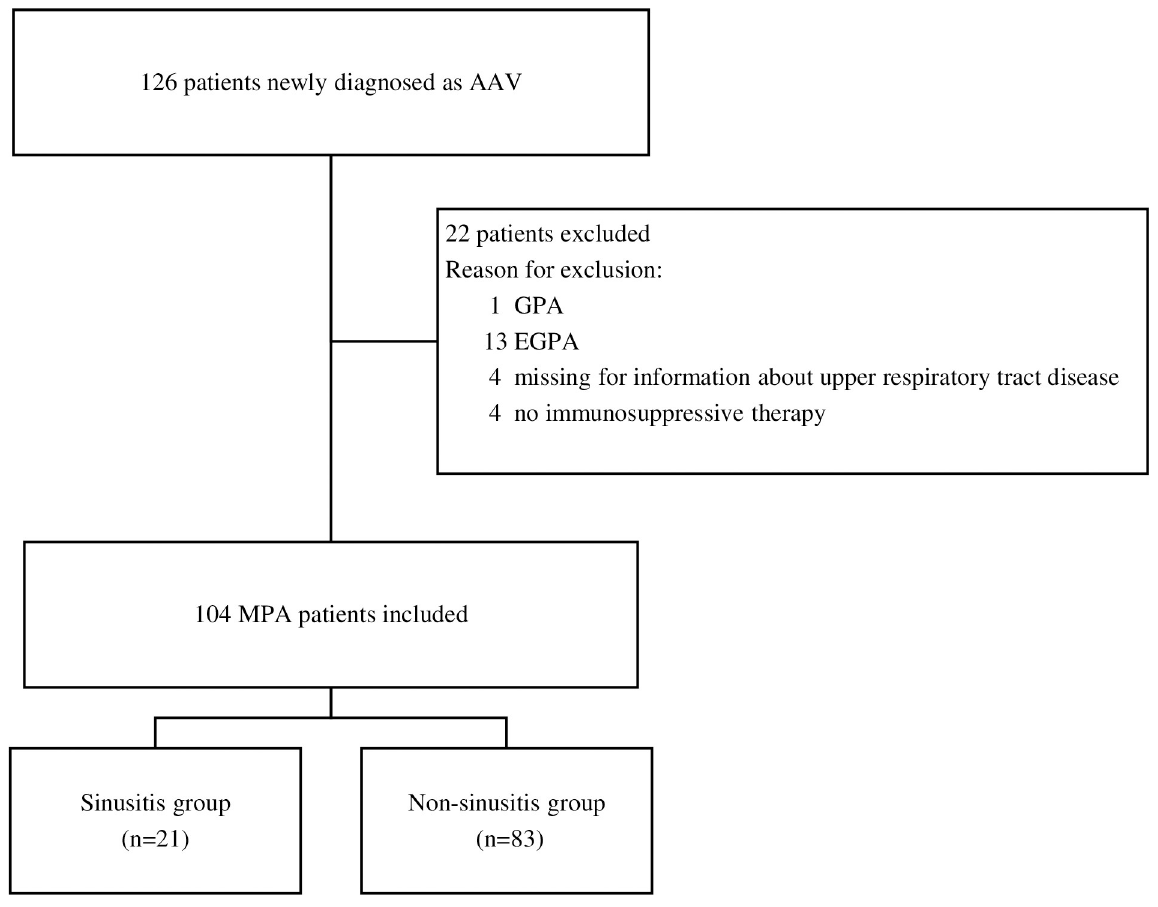
days), intravenous cyclophosphamide (CYC), and intravenous rituximab (RTX); initial dose